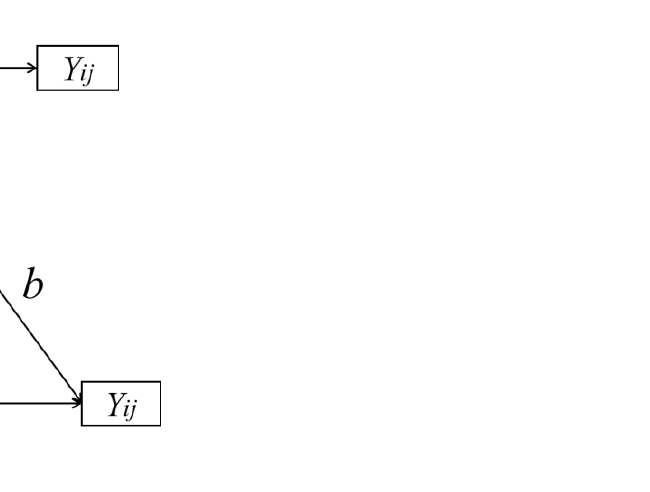
Figure 3. Multilevel mediating effect model. Note: Y ij represents the health of elder i in neighborhood j , which is a dependent variable; X j represents the built environment of neighborhood j , which is an independent variable; M ij represents the physical activity, neighborhood relationship, social network, and neighborhood activity participation of elder i in neighborhood j , which is the mediating variable.